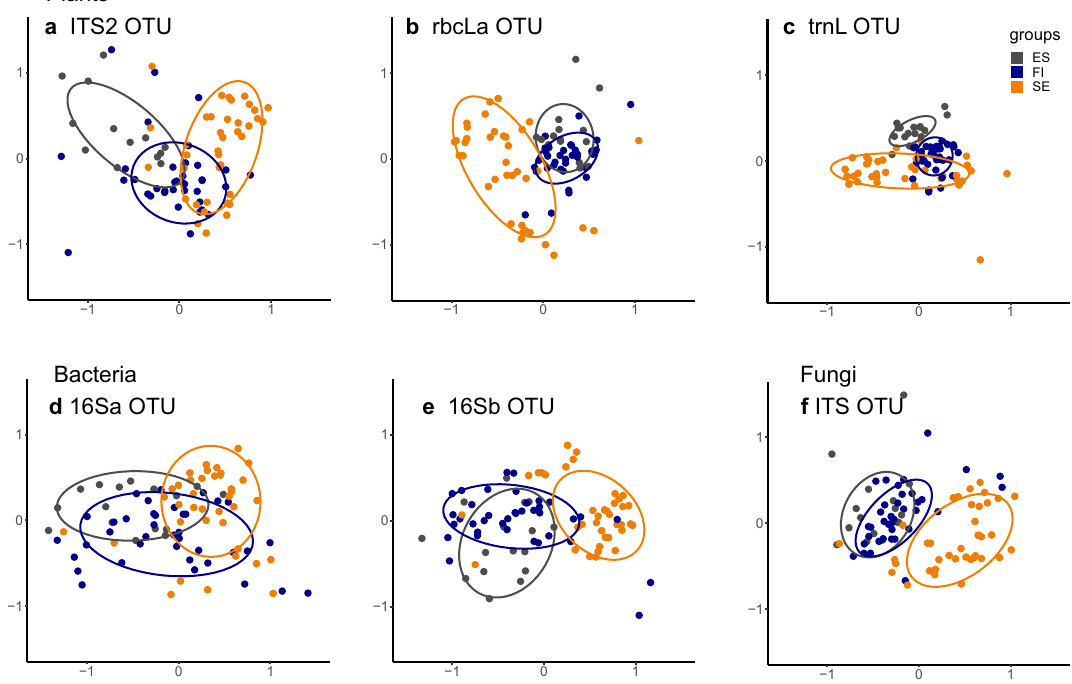
Figure 2. Nonmetric multidimensional scaling (NMDS) plots for plant, bacterial and fungal OTU community similarities among samples originating from the three different countries. The ellipses confine 75% of the data points. Stress values for the different gene region analyses are given in Supplementary Table S4. The panels show the data from different gene regions: plants: ( a ) ITS2, ( b ) rbc L a , ( c ) trn L, bacteria: ( d ) 16Sa, ( e ) 16Sb, and fungi: ( f ) ITS. Samples from Estonia (ES) are shown in gray, from Finland (FI) in blue and from Sweden (SE) in light